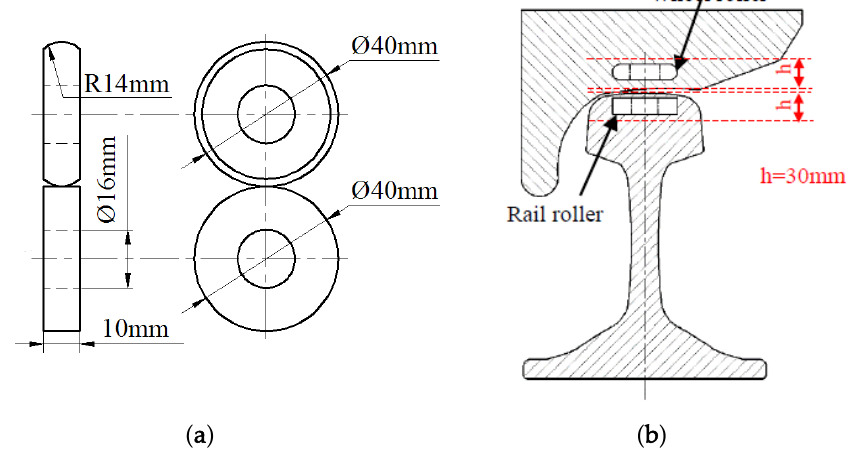
Figure 3. Dimensions and sampling position of wheel and rail rollers. (a) Dimensions; (b) sampling Dimensions and sampling position of wheel and rail rollers. ( a ) Dimensions; ( b ) position. sampling Table 1. Chemical composition of the wheel and rail rollers (wt%).